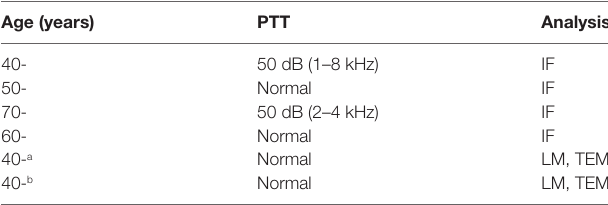
Table 1 | Patient data and methods of